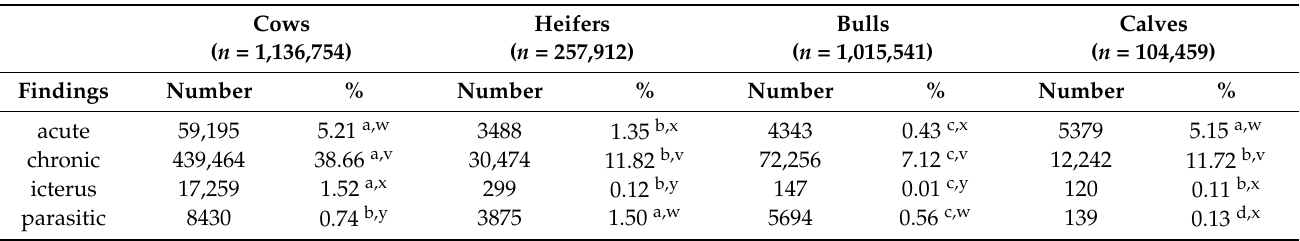
Table 2. Comparison of the occurrence of pathological findings in the livers of cows, heifers, bulls and calves slaughtered in slaughterhouses.